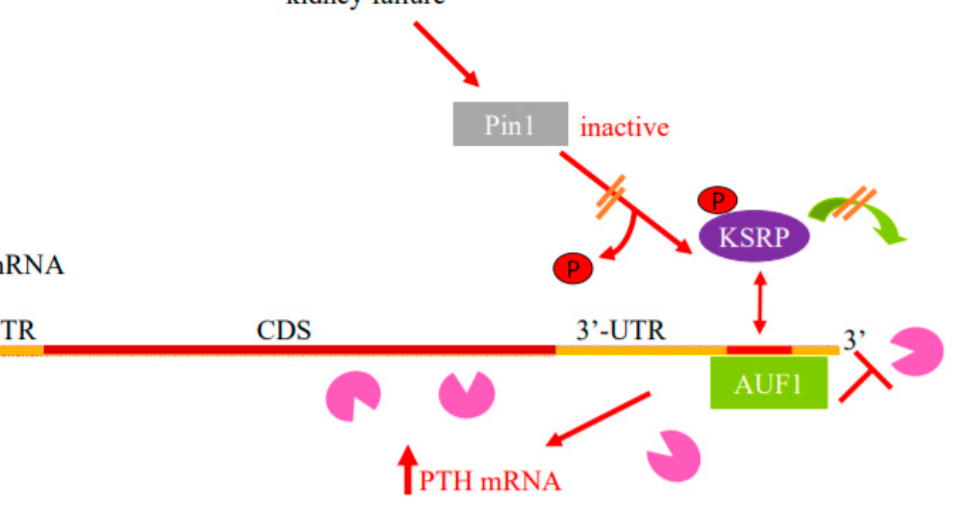
Figure 1. Model for the regulation of PTH mRNA stability in SHP by protein–PTH mRNA interactions and Pin1. Basal PTH mRNA levels are determined by a balanced interaction of the PTH mRNA 3 (cid:48) - UTR ARE with its stabilizing protein AUF1 and destabilizing protein KSRP that recruits the exosome (Pac-Man) to mRNAs. The isomerase Pin1 binds KSRP and induces KSRP Ser181 conformational change and dephosphorylation, which increases KSRP-PTH mRNA interaction and mRNA decay. In SHP, due to kidney failure or hypocalcemia, there is decreased parathyroid Pin1 isomerase activity and phosphorylated KSRP fails to bind PTH mRNA and recruit the exosome to it. As a result, AUF1 binds PTH mRNA with greater affinity, leading to increased PTH mRNA stability and levels. Schematic representation of the PTH mRNA with the coding sequence (CDS) in brown, the 5 (cid:48) - and 3 (cid:48) -untranslated regions (UTRs) in orange and ARE in red. AUF1, AU-rich binding factor 1;